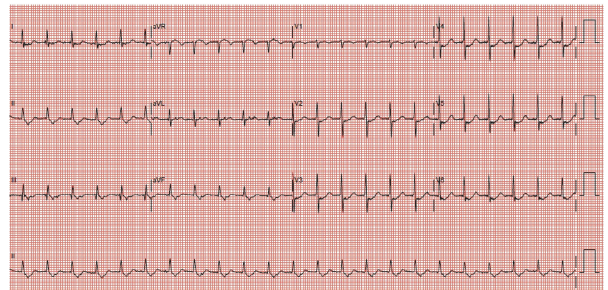
Figure 1: Patient A. Ventricular rate 149, SVT.